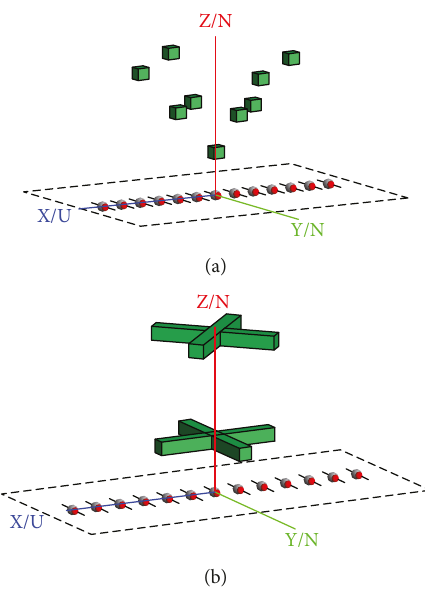
Figure 16: Setup in FEKO software for 3D imaging. (a) Example 1: One object is at z =0.5 λ plane at (0,0,0.5 λ ), four objects are at z = λ plane at ( ± λ /2,0, λ ) and (0, ± λ /2, λ ), and four objects are at z =1.5 λ plane at ( ± λ ,0,1.5 λ ) and (0, ± λ ,1.5 λ ). Objects are square shape with side of λ /8 . (b) Example 2: Two X-shape objects with an arm length of 1.2 λ and cross-section of each arm being square with a side of λ /8. One objects is placed at z =0.5 λ with it arms along x and y -axis, and the second object is placed at z =1.5 λ with its arms rotated 45 ° with respect to x and y